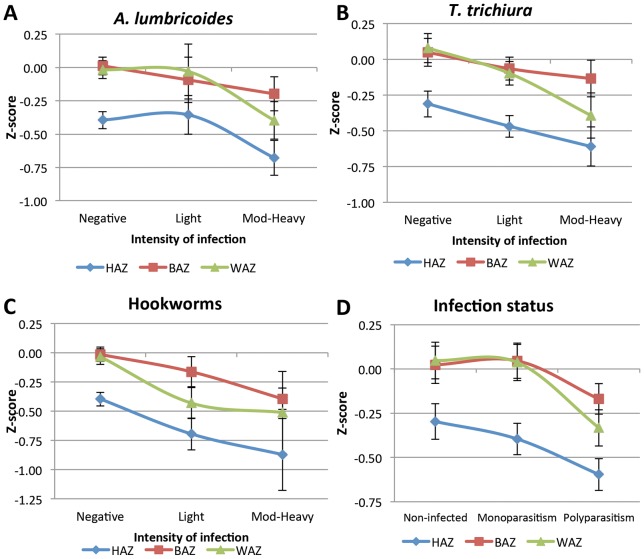
Plots of Z-scores for anthropometric indicators vs. STH intensity of infection/infection status.A decreasing trend in Z-scores was observed as intensity of infection increased (plots A–C) and as the number of species parasitizing increased (plot D). HAZ: height-for-age Z-score; BAZ: BMI-for-age Z-score; WAZ: weight-for-age Z-score. Mod-Heavy: infections of moderate-to-heavy intensity.